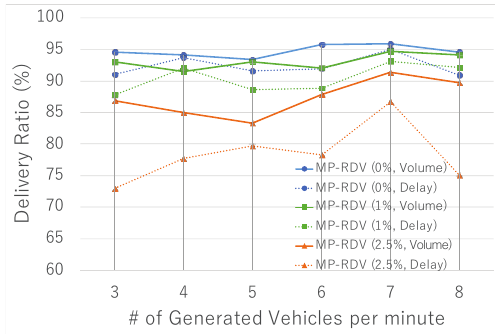
Figure 16. Metric Comparison in Failure